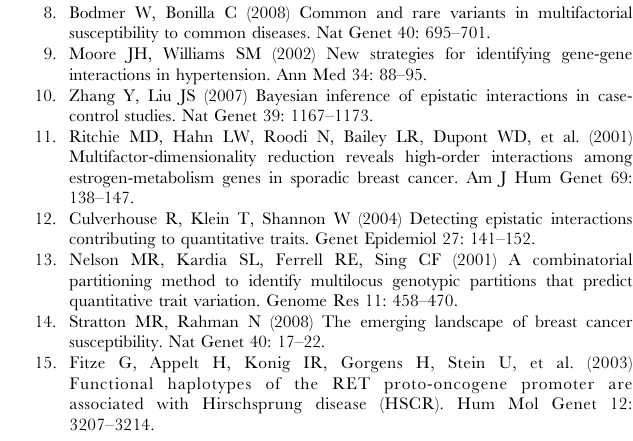
Table S3 Rare variant summary statistics. The summary statistics are displayed for the generated replicates under main effects model with fixed and variable genetic effects. Estimated SFS from AA population with ANGPTL dataset was used.